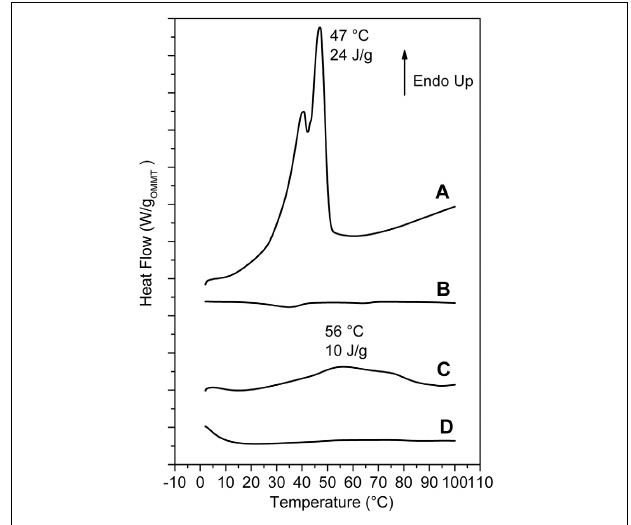
FIGURE 3 | DSC heating scans of: (A) as received MMT/2HT (intercalated); (B) MMT/2HT after treatment by scCO 2 (exfoliated); (C,D) aerogels with 90% of porosity, with 50/50 weight ratio of s-PS/as received OMMT (C) and of sPS/exfoliated OMMT (D).